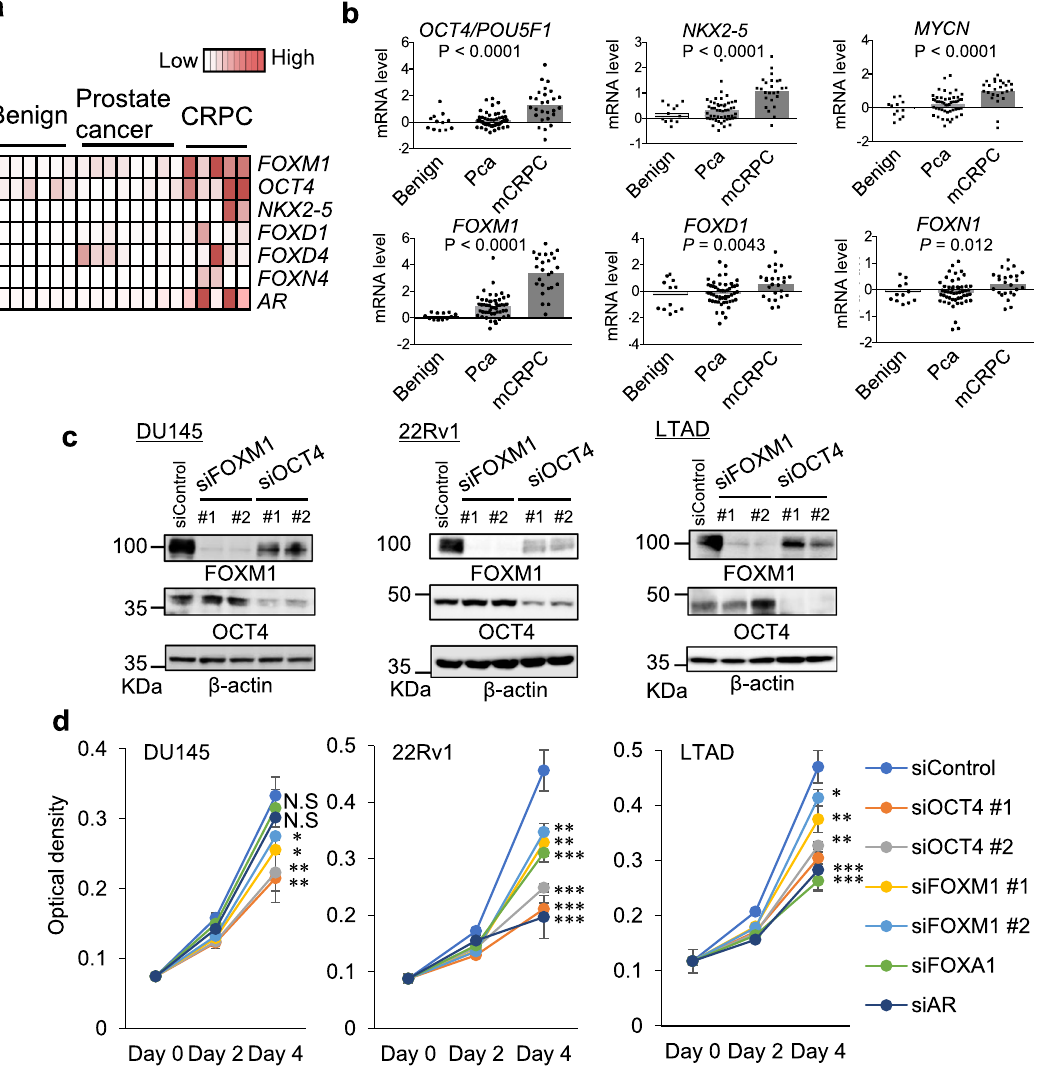
Fig. 1 Identi fi cation of distinct TF networks in advanced PC that contributes to the aggressiveness. a Heatmap of TFs in benign prostate, primary PC, and CRPC tissues. Average RNA-seq results (RPKM) are summarized. Benign N = 6, Prostate cancer N = 8, CRPC N = 5. b Publicly microarray data (GSE35988) used for gene expression analysis. Pca: prostate cancer, mCRPC: metastatic CRPC. Two-sided Mann – Whitney test was performed between Pca and mCRPC. Benign N = 12, Pca N = 51, mCRPC N = 25). c Knockdown of FOXM1 and OCT4 expression by siRNAs. d Cell proliferation assay of multiple PC cells transfected with siControl or two siRNAs targeting indicated TFs. MTS assay was used to quantify the cell growth rate ( N = 4, biological independent). N.S not signi fi cant, * P < 0.05, ** P < 0.01, *** P < 0.001. two-sided t -test was performed. Data are presented as average ± S.D. Source data are provided as a Source Data fi